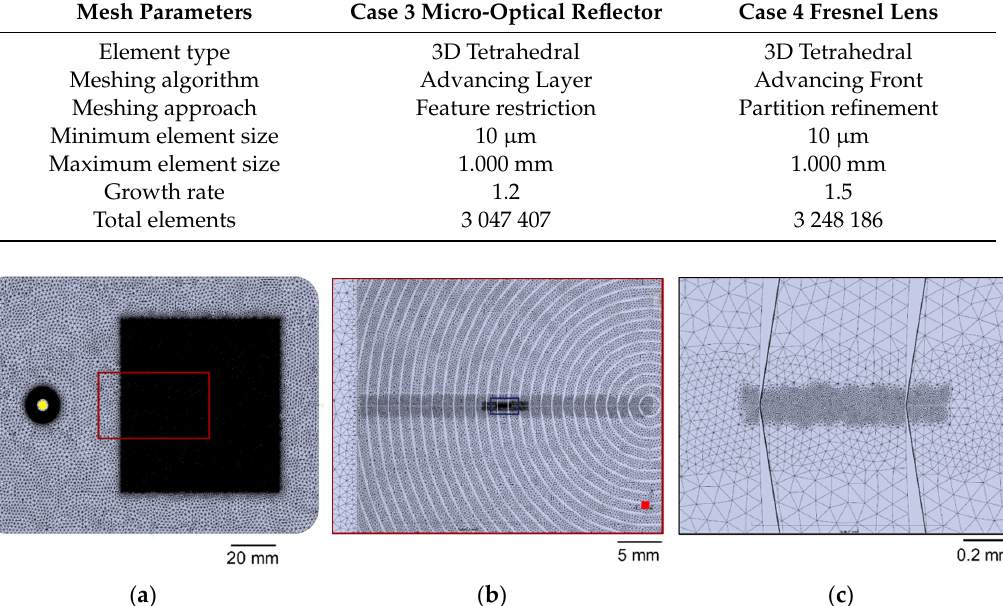
Figure 14. The multi-scale mesh of the Fresnel lens with partial surface mesh refinement at ( a ) part level, ( b ) structured area level, and ( c ) at single micro feature level. Table 4. Multi-scale meshing parameters for the micro-structured plastic parts.